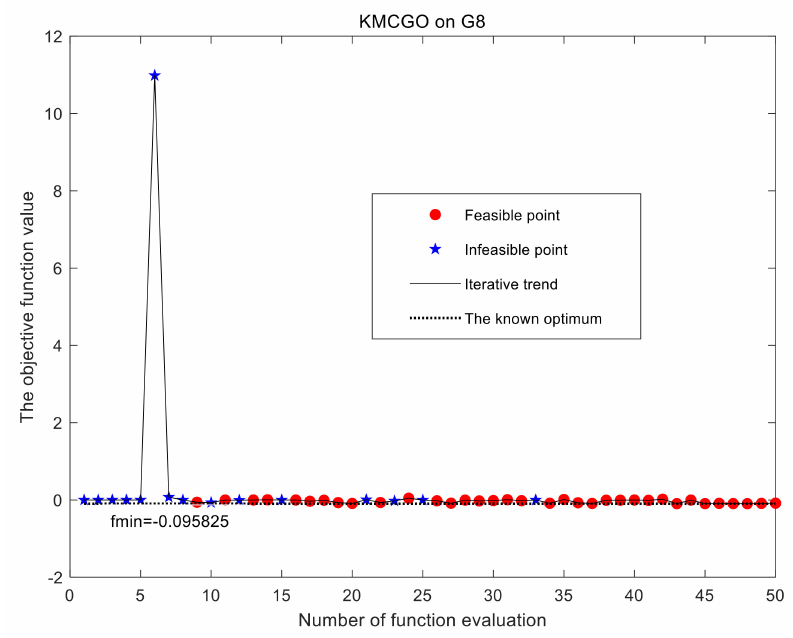
Figure 4. Iteration result of the G8 function.